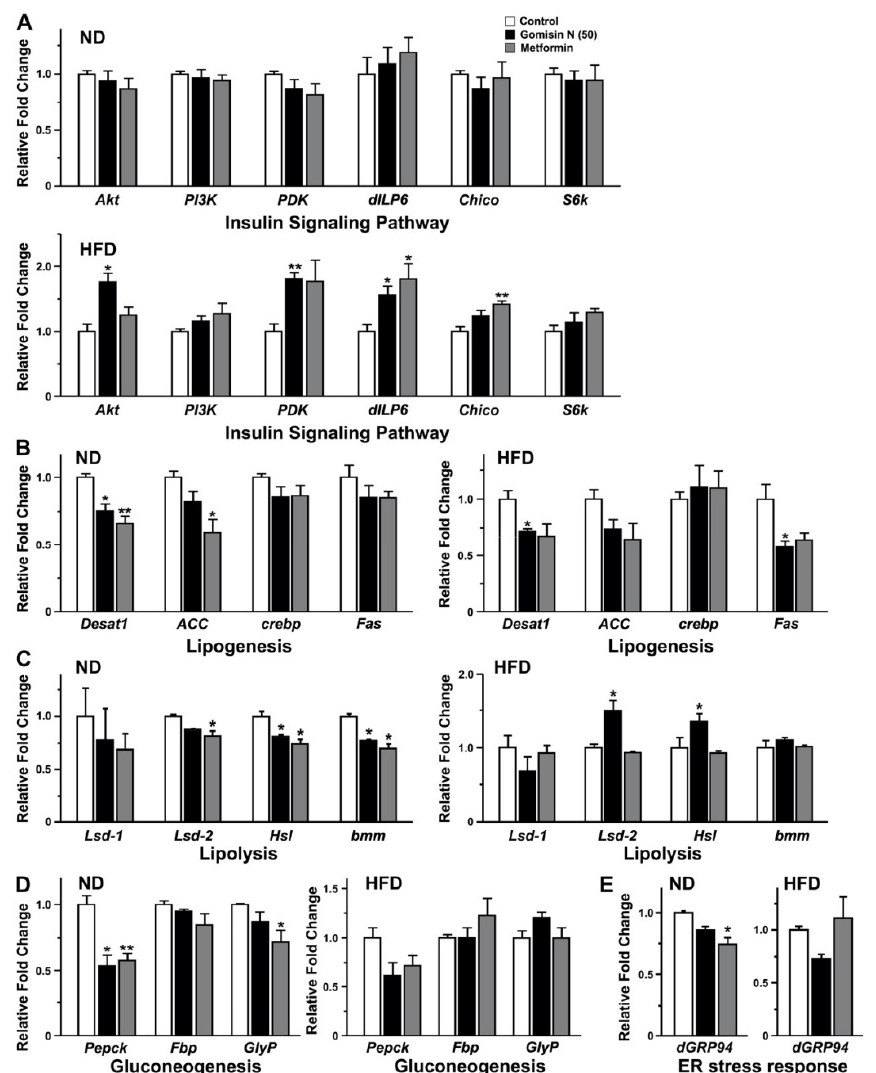
Figure 4. The effects of gomisin N on insulin signaling, lipogenesis, lipolysis, gluconeogenesis, and endoplasmic reticulum (ER) stress response in adult flies. The transcript levels of genes involved in insulin signaling ( A ), lipogenesis ( B ), lipolysis ( C ), gluconeogenesis ( D ), and ER stress response ( E ) are compared among adult flies fed with vehicle (control, white), gomisin N (50 μ g/mL) (black), or metformin (10 mM) (gray). Comparisons of gene expression were performed with RT-qPCR